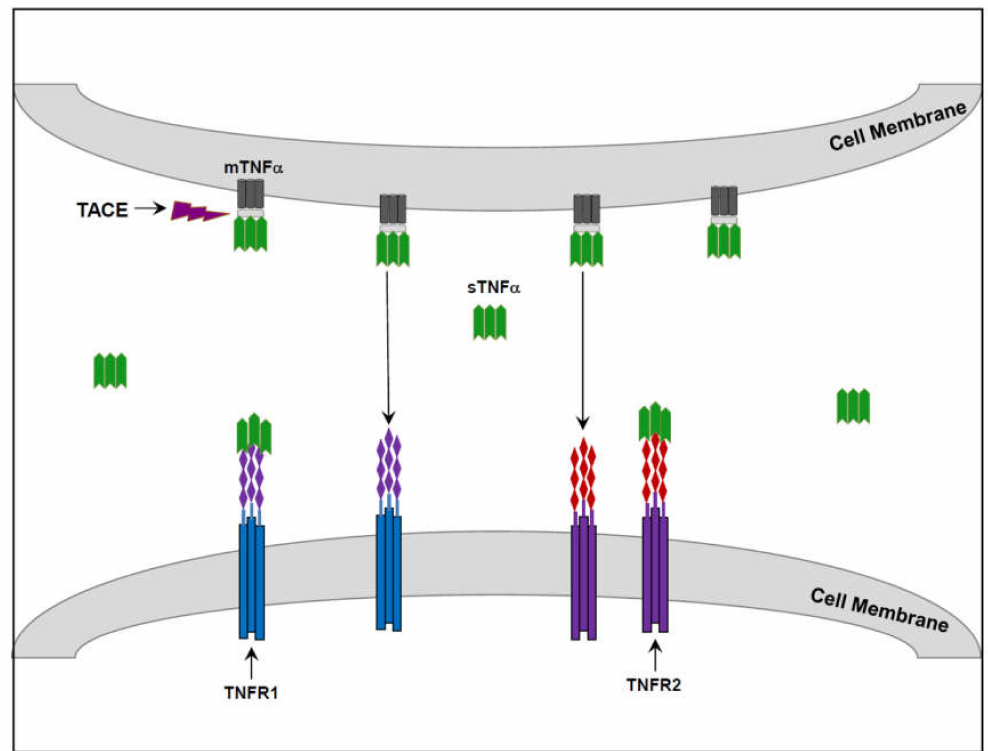
Figure 1. TNF- α and TNF- α Receptors. Transmembrane TNF- α (mTNF- α ) undergoes proteolytic cleavage by TNF- α - converting enzyme (TACE) which generates the soluble form of the protein (sTNF- α ). Both mTNF- α and sTNF- α are biologically active; they bind to and activate TNF receptor (TNFR) 1 and TNFR2. Arrows indicate that mTNF- α is also capable of activating TNFR1 and